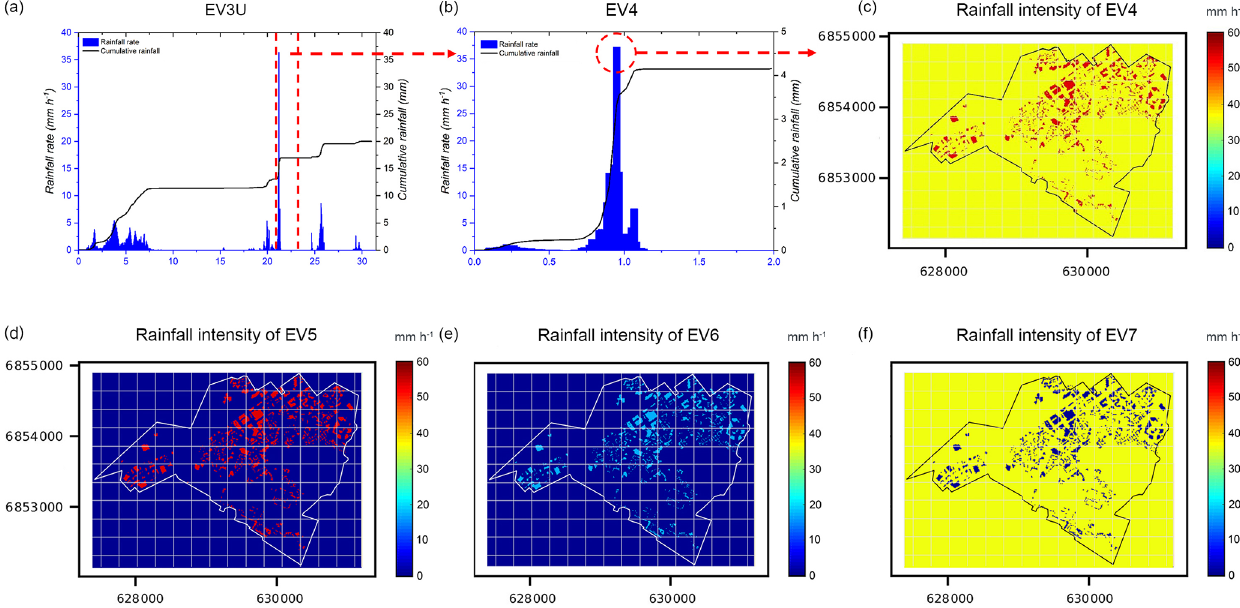
Figure 4. (a) Time evolution of rainfall rate (millimetres per hour) and cumulative rainfall (millimetres) of the EV3U over the whole catchment (the period between the red dashed lines is the selected period for creating the EV4). (b) Time evolution of catchment-averaged rainfall rate and cumulative rainfall of the EV4 over the whole catchment. (c) The rainfall intensity at the largest rainfall peak (distributed) over the Guyancourt catchment for the EV4 (the red pixels are the location of green roofs (GRs) in GR1 scenario with the highest rainfall intensity in space), the rainfall of other areas are uniform. (d–f) The rainfall intensity at the largest rainfall peak (distributed) over the Guyancourt catchment for the EV5, EV6, and EV7,